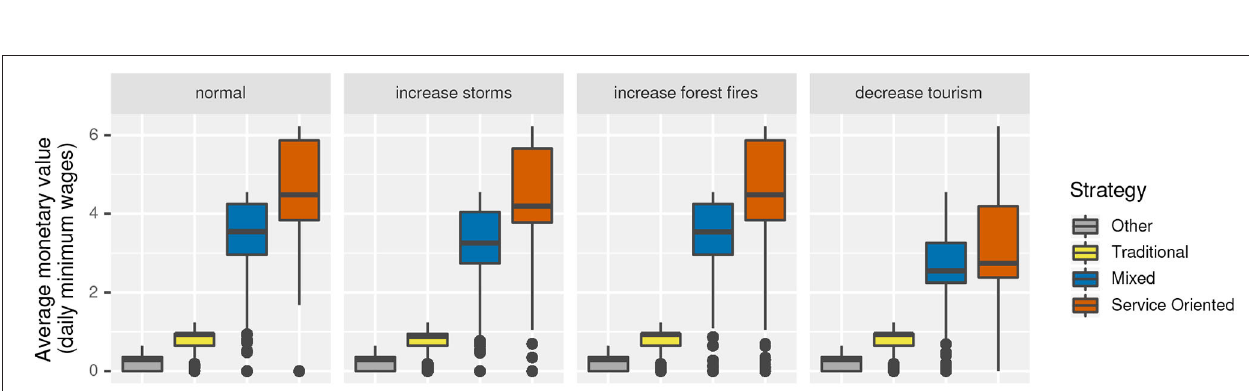
Frontiers in Sustainable Food Systems | www.frontiersin.org